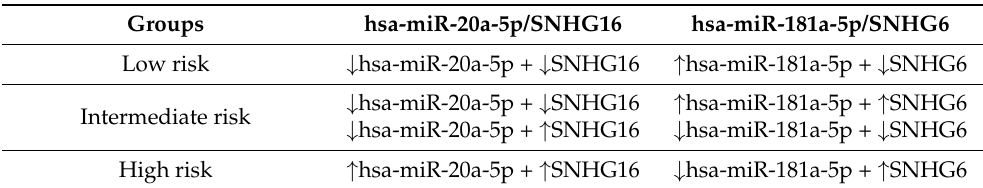
Table 2. Definition of high-, intermediate- and low-risk groups considering the combination of the plasma levels of each ceRNA pair, hsa-miR-20a-5p/SNHG16 and hsa-miR-181a-5p/SNHG6 plasma levels(upwards arrow represents transcript upregulation, downwards arrow represents transcript downregulation).